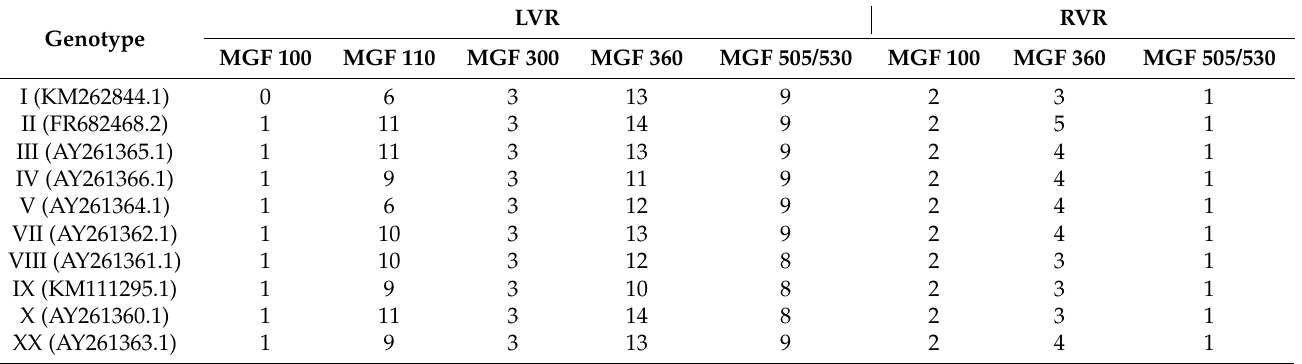
Table 1. Number of MGF members present in the LVR and RVR of different genotypes of ASFV genomes.